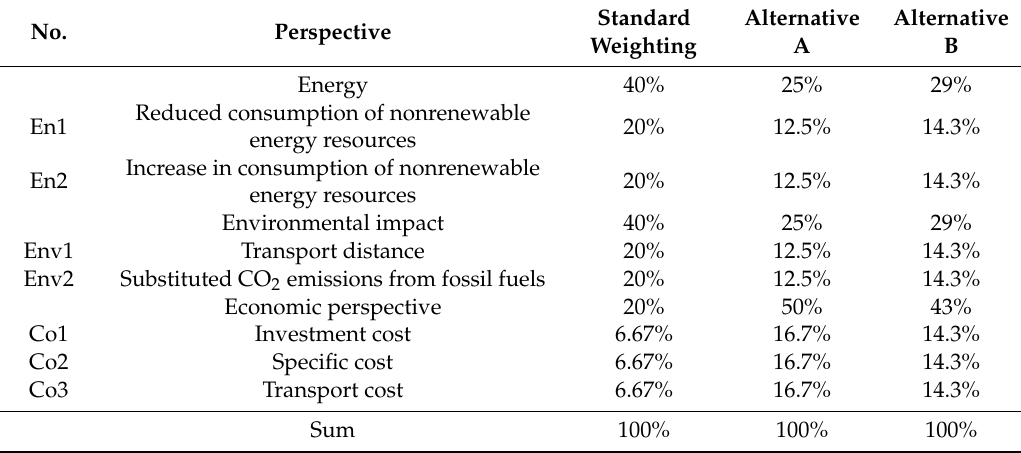
Table 7. Standard and alternative weighting for each evaluation